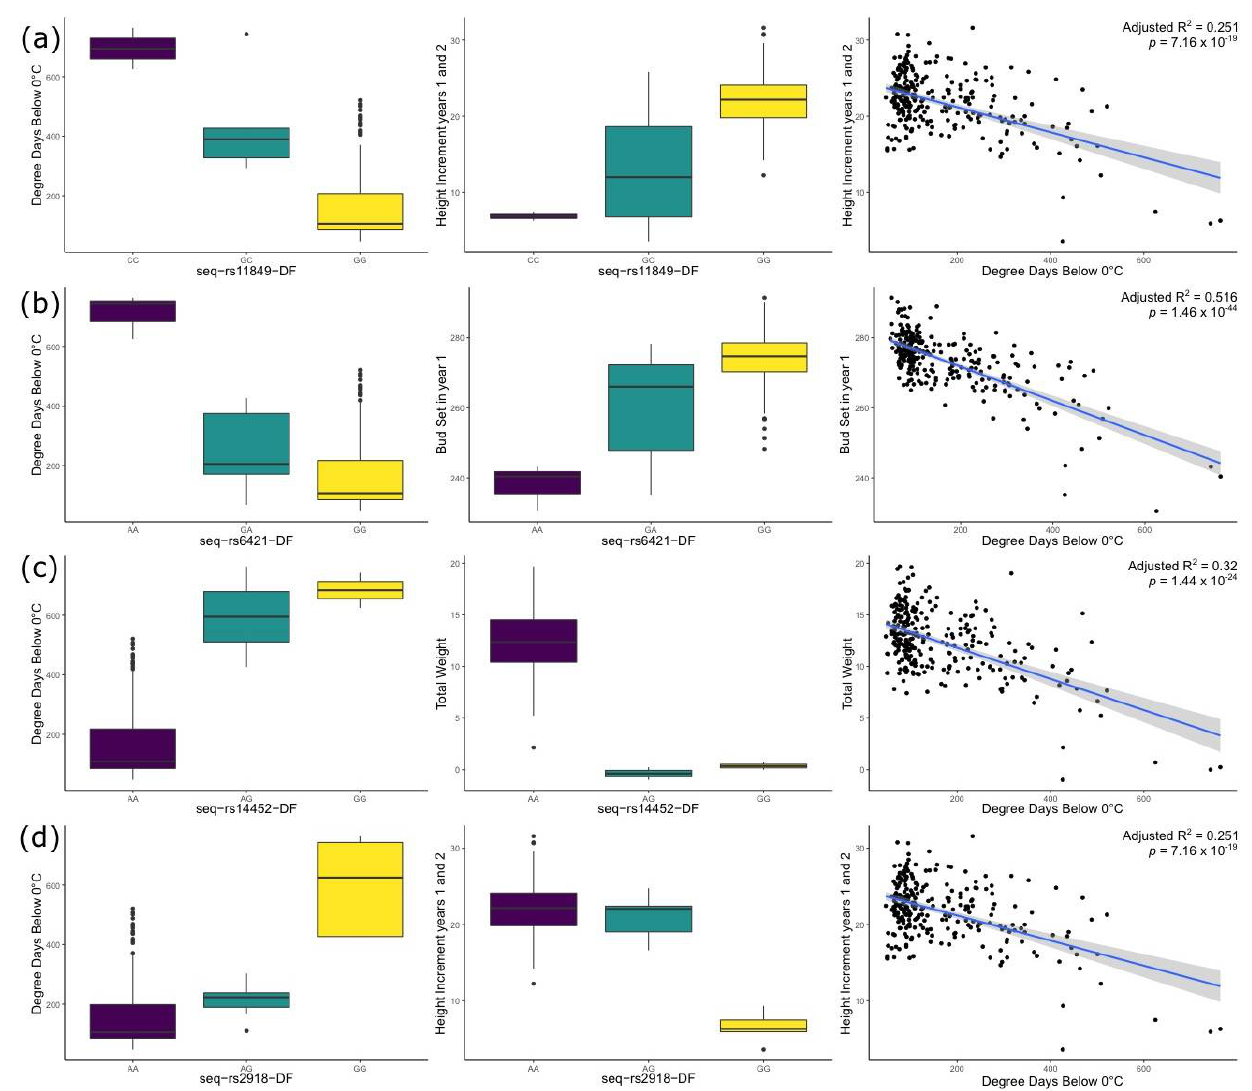
Figure 3. SNPs showing significant associations with cold-related traits and environmental variables in all univariate and multivariate GWAS and GEA analyses. ( a ) SNP seq-rs11849-DF (gene PSME_39361, 1-deoxy-D-xylulose